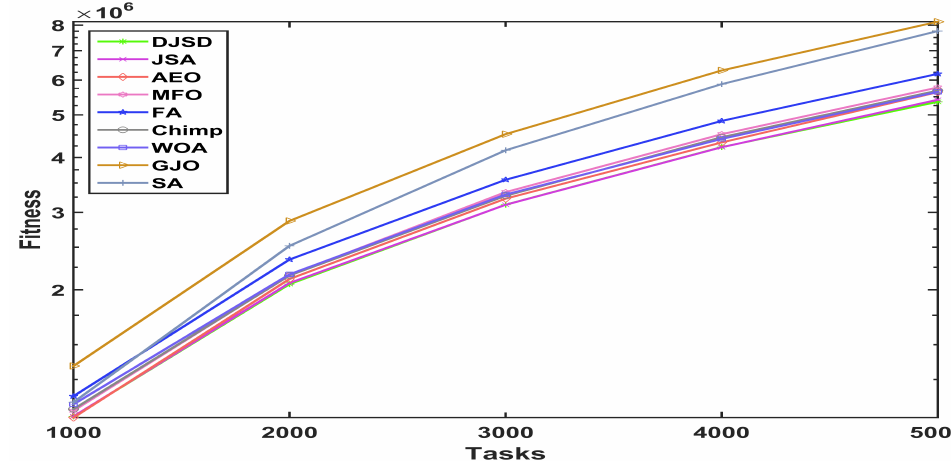
Figure 5. Convergence curve for NASA iPSC real workload.